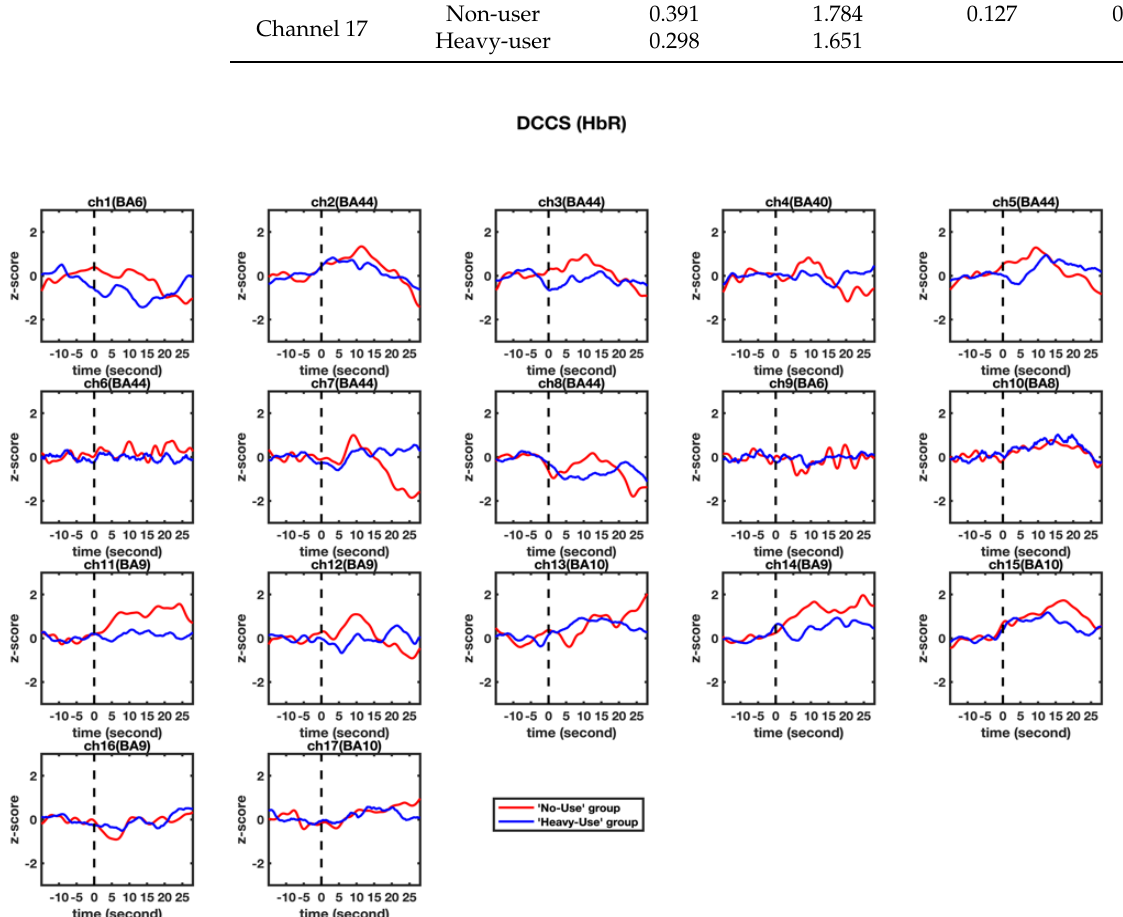
Figure 5. Observed changes in the HbR concentration in the 17 channels during the DCCS tasks. The HbR data for the ‘non-user’ and ‘heavy-user’ group are shown in red and blue line, respectively.